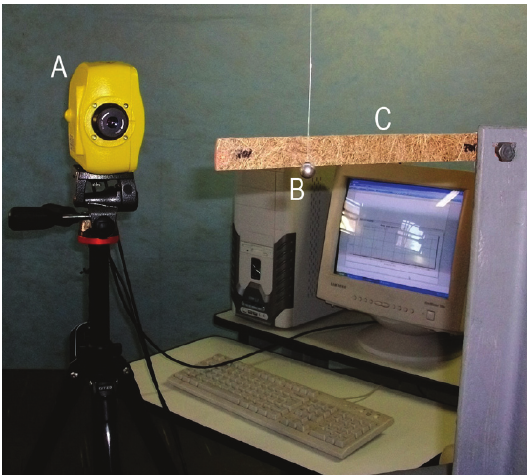
Figure 3. Measurement system composed by A) vibrometer, B) pendulum and C) beam.